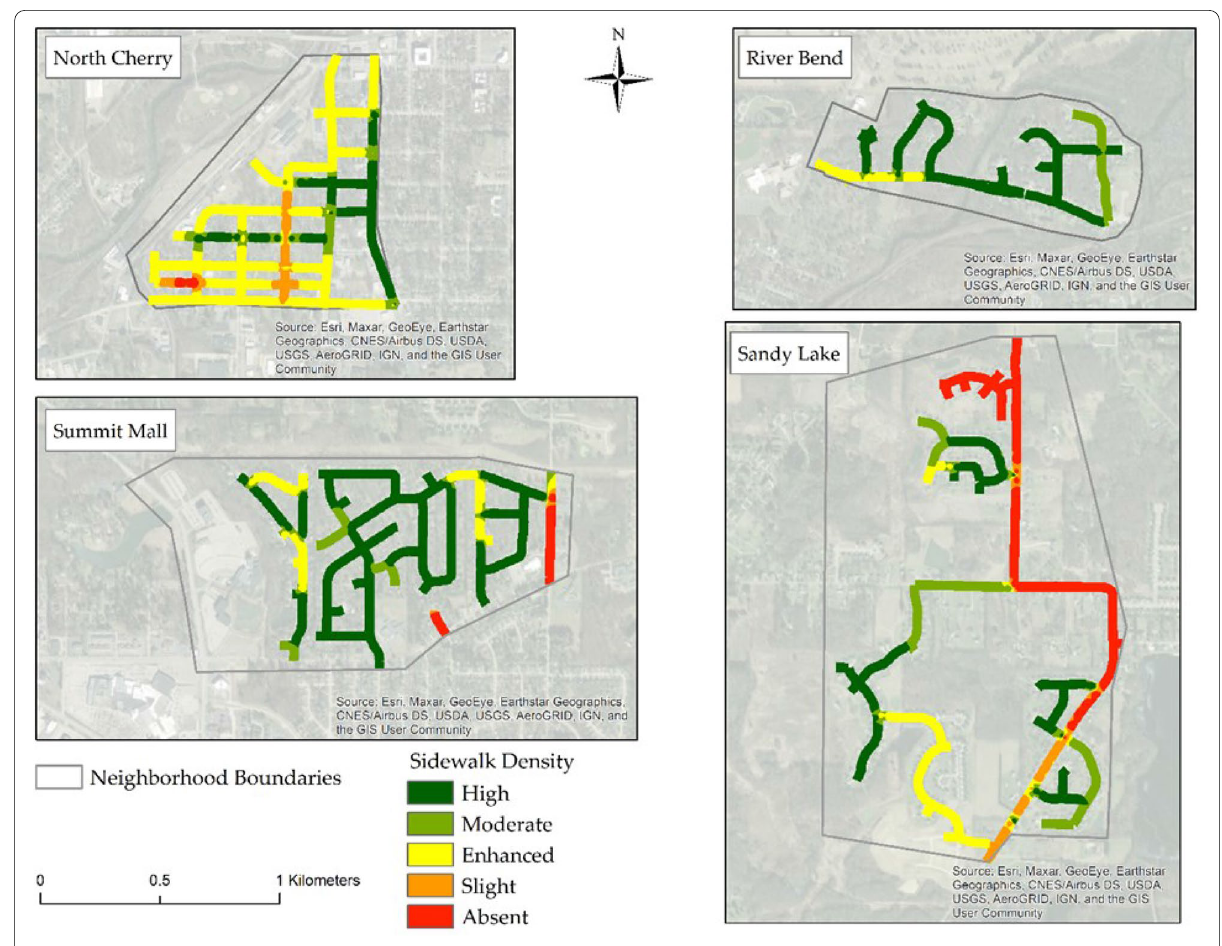
Fig. 9 The spatial distribution of